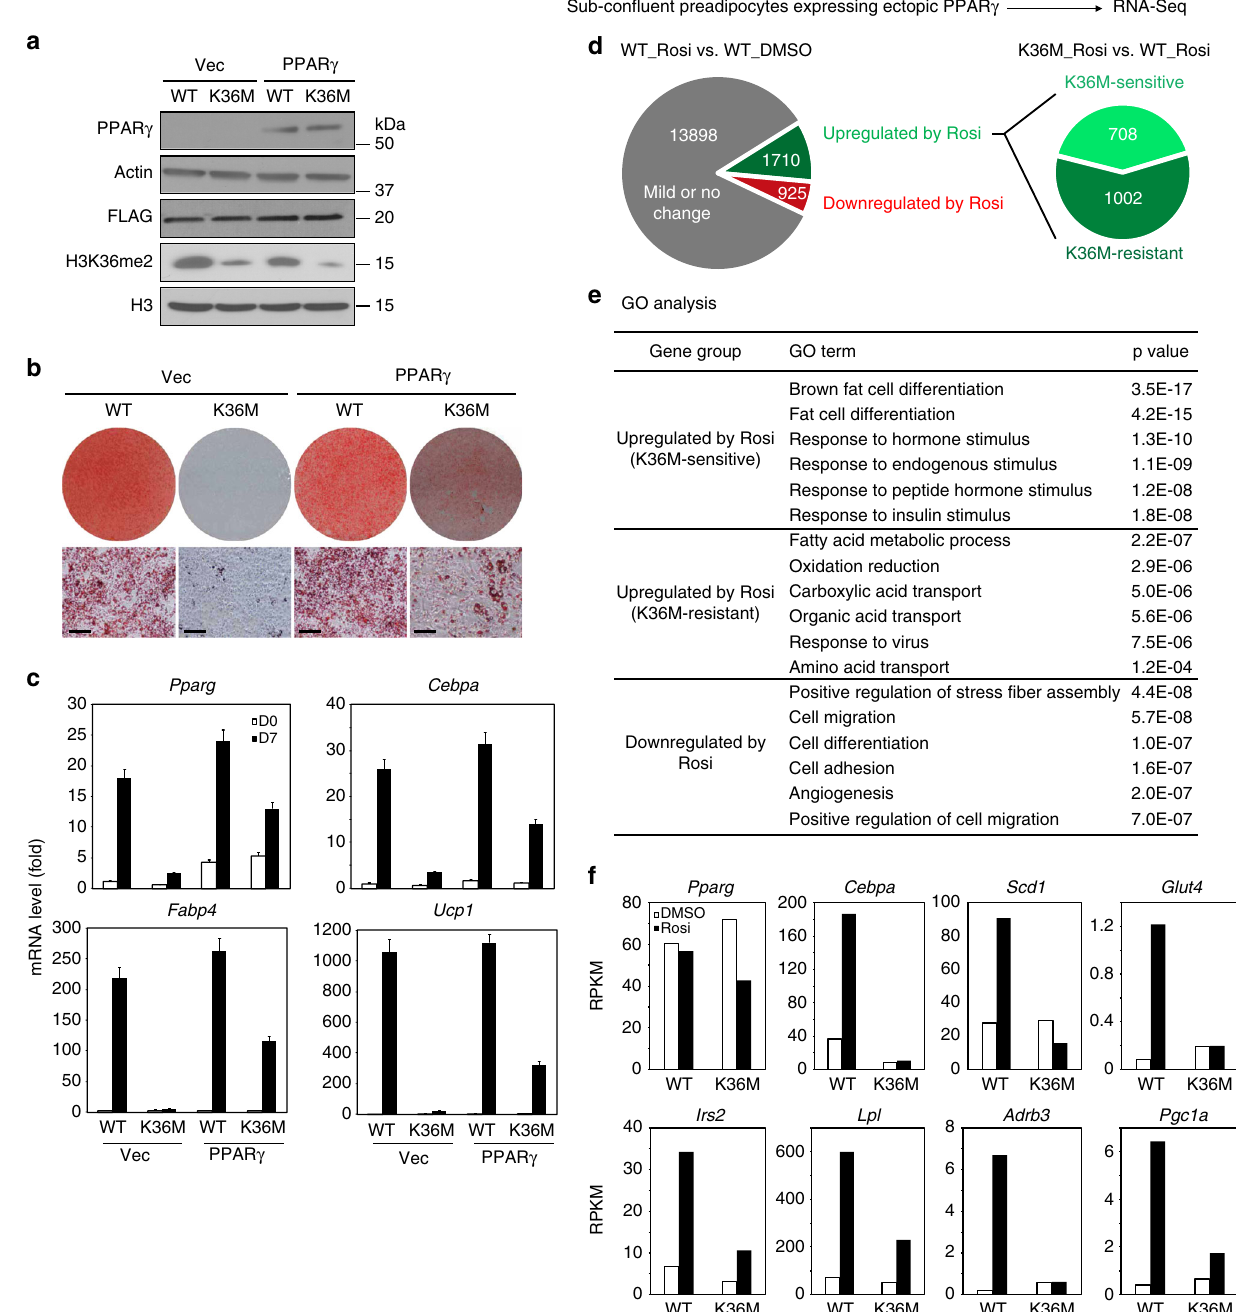
Fig. 2 H3.3K36M inhibits ligand-induced PPAR γ target gene expression. Immortalized brown preadipocytes were infected with retroviral vector expressing FLAG-tagged WT or K36M mutant histone H3.3. After puromycin selection, cells were infected with retroviral vector expressing PPAR γ or empty vector, followed by hygromycin selection. a Western blot analysis in preadipocytes using antibodies indicated on the left. b Oil Red O staining at D7 of adipogenesis. Scale bars = 30 μ m. c qRT-PCR of Pparg , Cebpa , Fabp4 , and Ucp1 expression at D0 and D7 of adipogenesis. qRT-PCR data are presented as means ± SEM. Three technical replicates from a single experiment were used. d – f Sub-con fl uent preadipocytes expressing ectopic PPAR γ were treated with DMSO or 0.5 μ M PPAR γ ligand Rosiglitazone (Rosi) for 24 h, followed by RNA-Seq analysis. d Schematic of identi fi cation of K36M-sensitive and K36M- resistant genes up-regulated by Rosi treatment. The threshold for up-regulation or down-regulation is twofold. e GO analysis of gene groups de fi ned in d . f RPKM values of Pparg and representative PPAR γ target genes from RNA-Seq